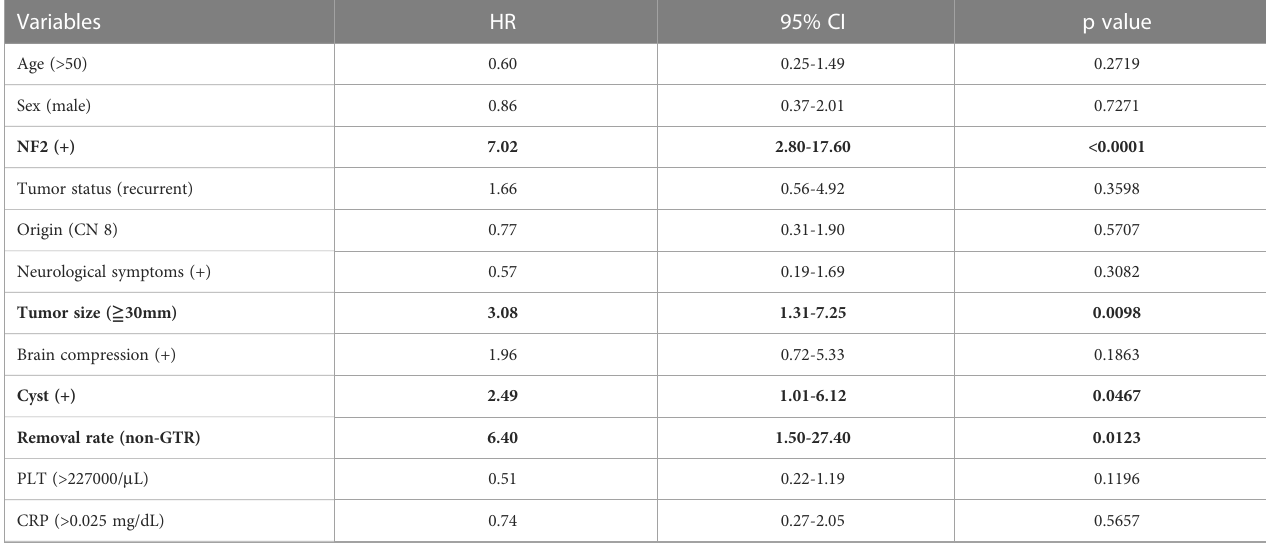
TABLE 2 Univariate Cox proportional hazards regression